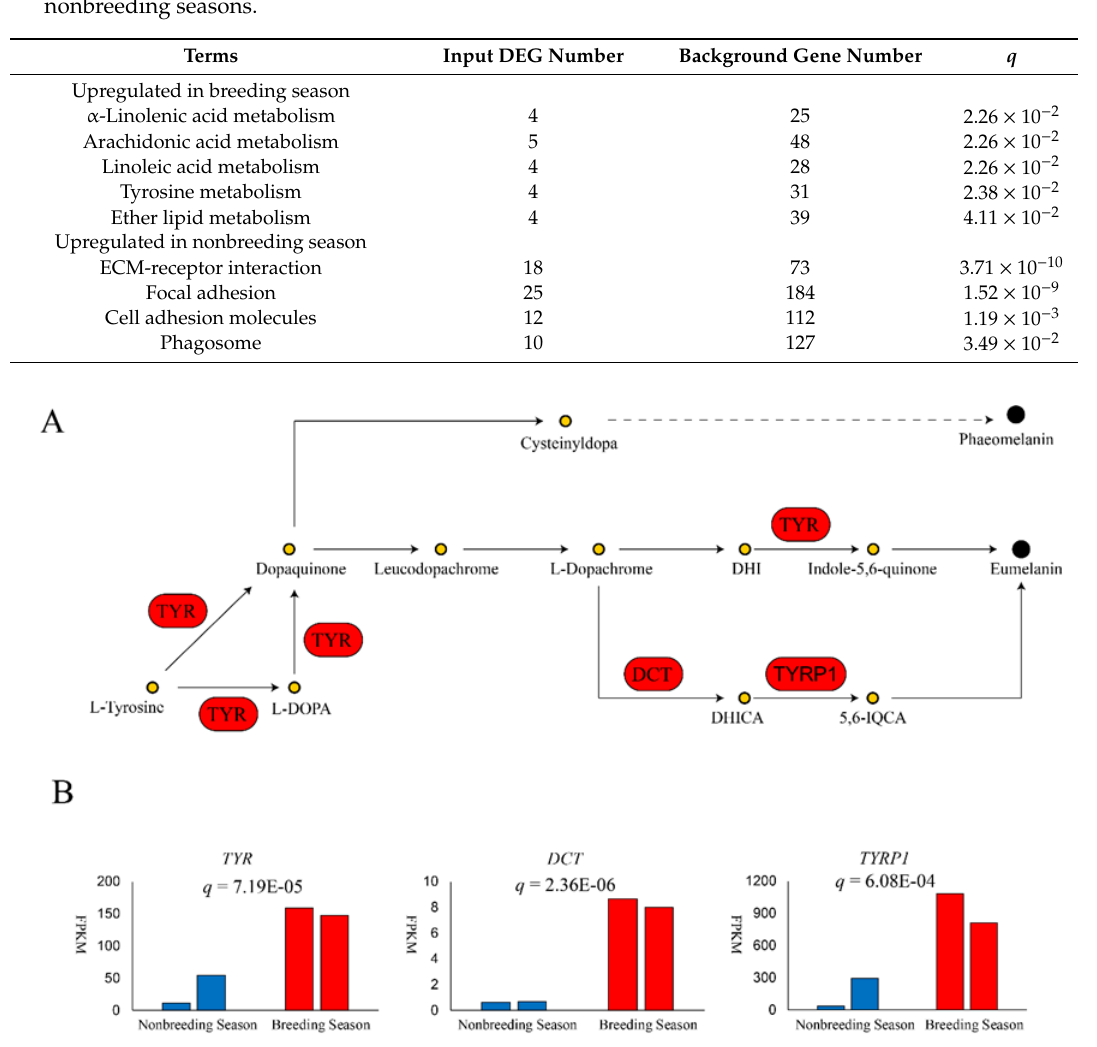
Figure 3. Upregulation of key genes in synthesis of eumelanin in breeding season. ( A ) shows the process of eumelanin and pheomelanin synthesis. ( B ) gives a comparison of expression of three genes TYR , DCT , and TYRP1 in eumelanin synthesis. The vertical axis of three bar graphs represents the fragments per kilobase of transcript sequence per million base pairs (FPKM) sequenced of each gene. Adjusted p values are shown as q in each bar graph. Table 3. Enriched KEGG pathways upregulated in black skins of the crested ibises in breeding and nonbreeding seasons.